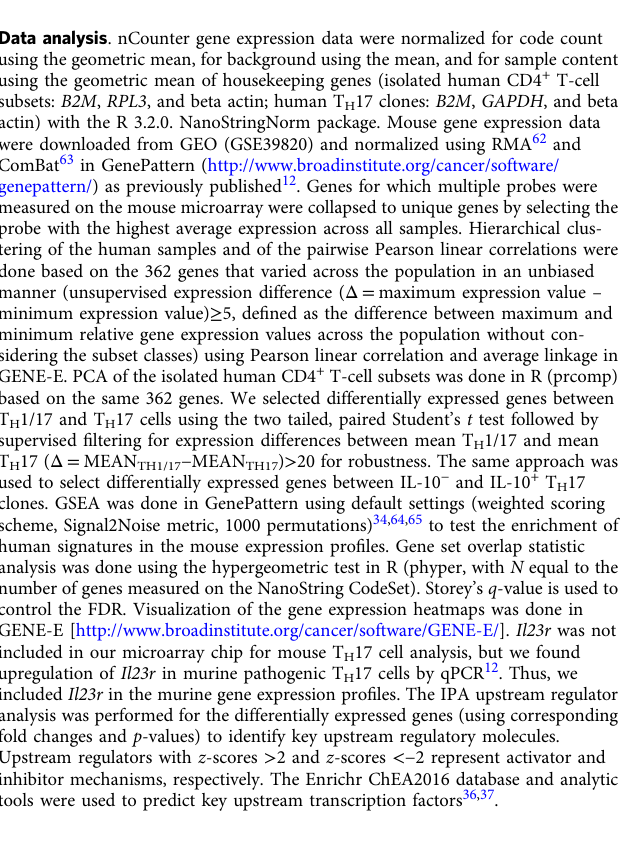
1:800) production. IL-10 – and IL-10 + T H 17 clones were selected for further analysis. Regular quantitative real-time PCR . To measure gene expression in T H 17 clones with qPCR, IL-10 – and IL-10 + T H 17 clones from an individual donor were pooled.